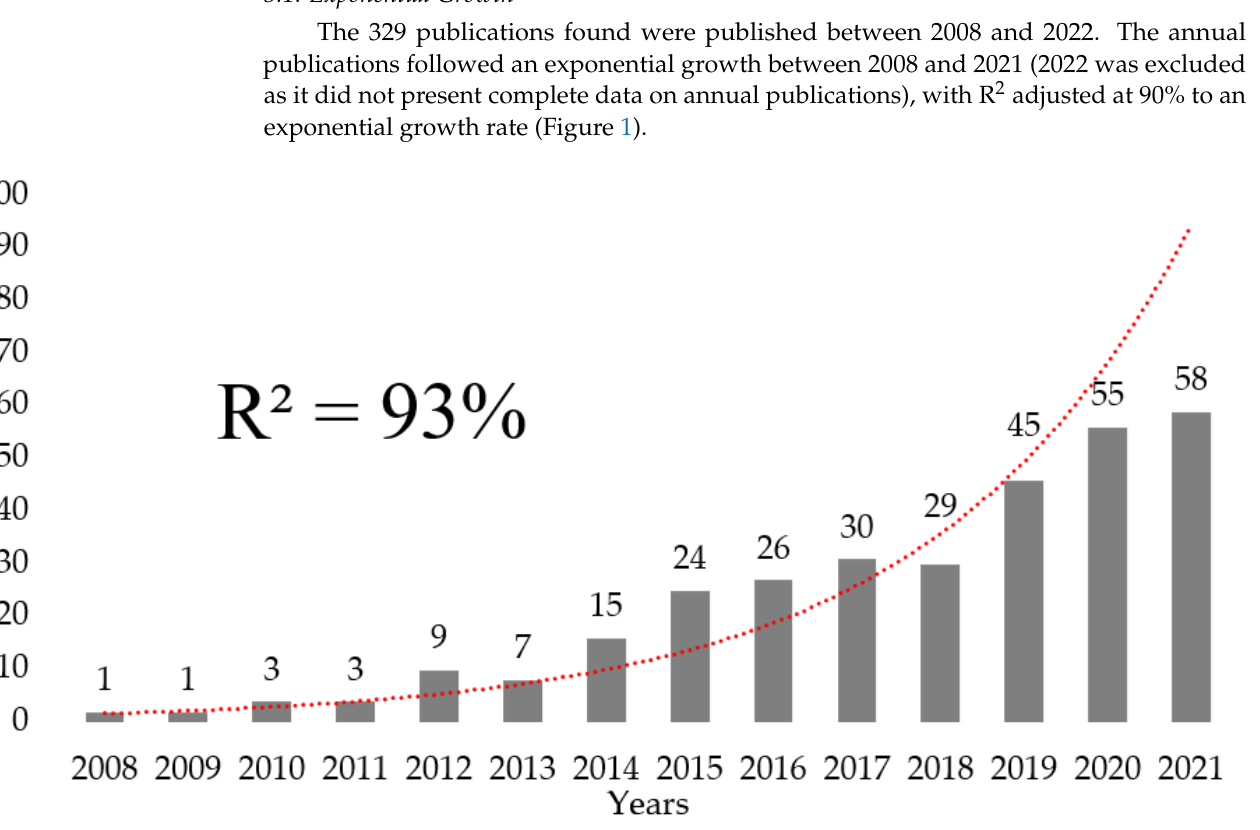
Table 1. Top 10 Web of Science (WoS) thematic categories according to the number of publications.